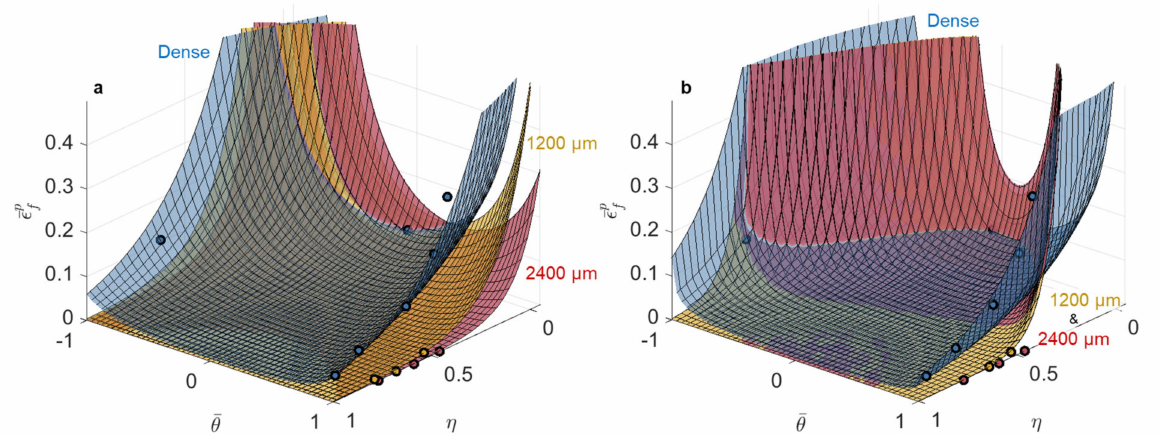
Figure 5. Calibrated ( a ) modified Mohr–Coulomb and ( b ) Hosford–Coulomb fracture loci in stress triaxiality vs. Lode angle parameter vs. equivalent plastic strain space for Ti-6Al-4V using dense, 1200 µ m, and 2400 µ m pore data. Note that the horizontal positions of each symbol correspond to the average stress triaxiality and Lode angle parameter during loading, while the vertical position corresponds to the experimental strain to failure of the average stress state under the assumption of proportional loading; therefore the symbols are not expected to lie on the fracture surfaces, which took into account loading history in the accumulation of